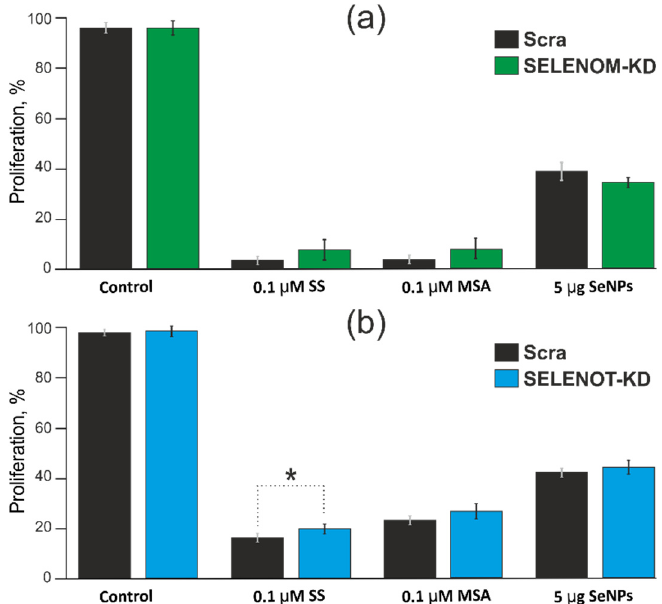
Figure 8. Comparison proliferation assay performed by MTT. Analysis the proliferation of A–172 cells before and after SELENOM-KD ( a ) or SELENOT-KD ( b ) after treatment with 0.1 µM SS, 0.1 µM MSA and 5 µg/mL SeNP 24 h. The optical density at 590 nm was measured, and the values of the respective untreated cells were defined as 100%. Standard deviations were determined by analysis of data from at least three independent experiments and are indicated by error bars. * p < 0.05.